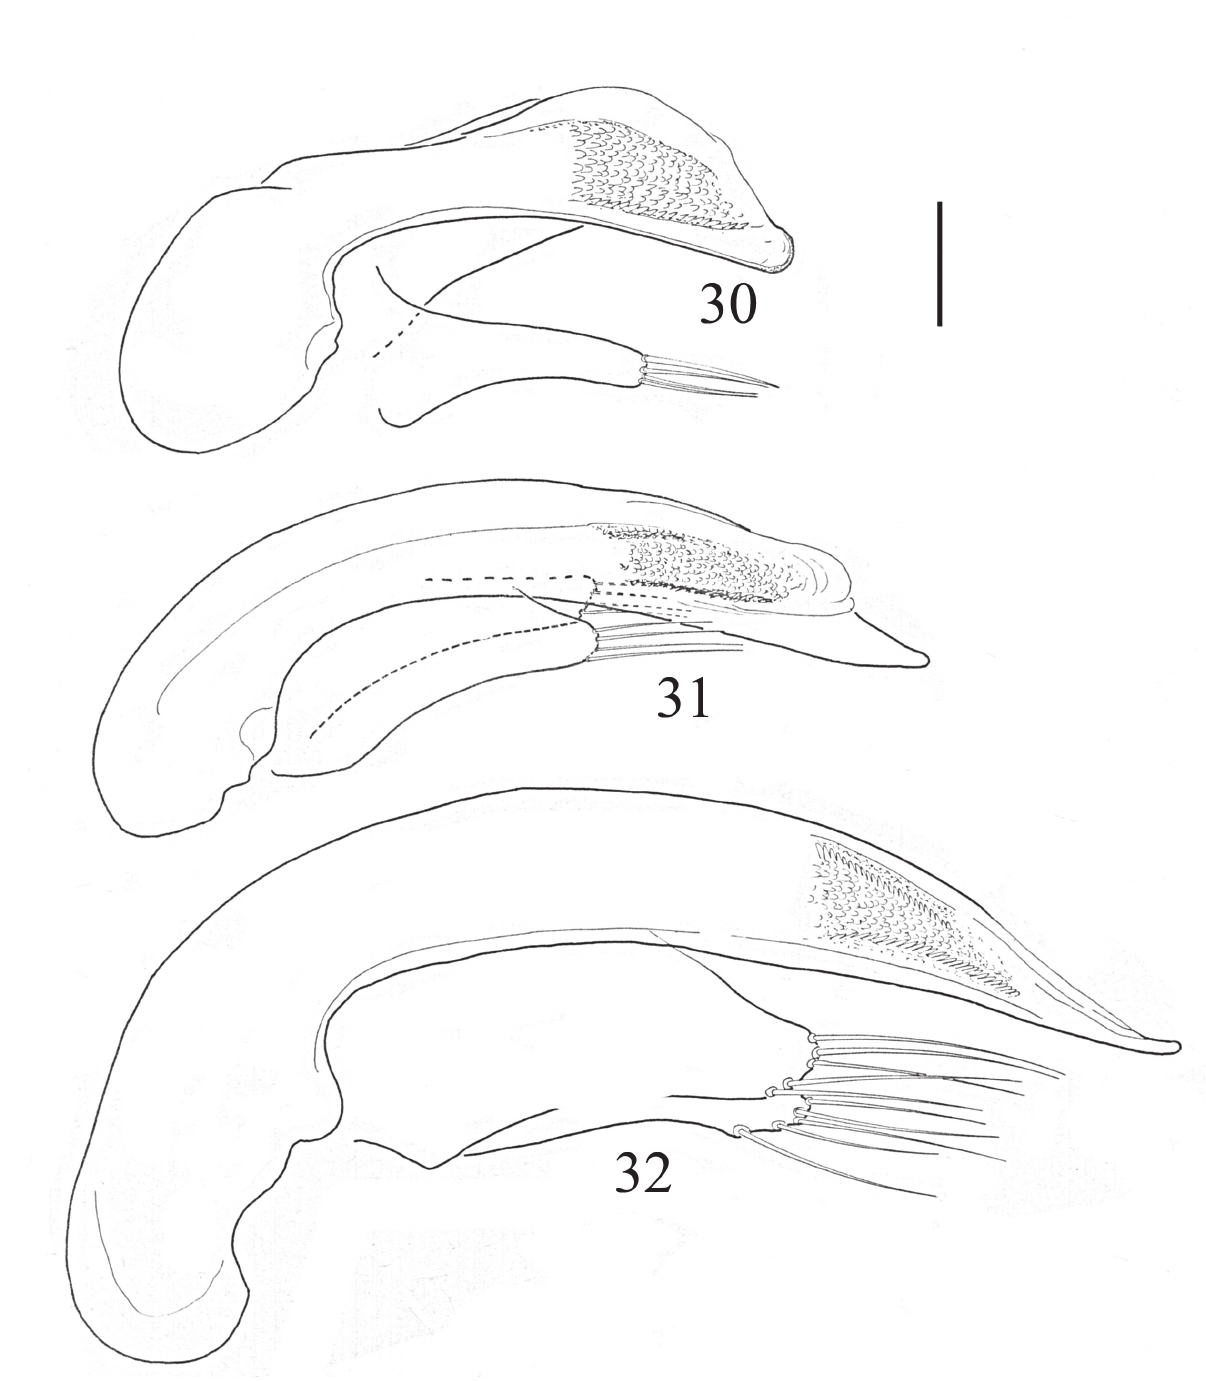
Figs 30-32. Aedeagus in lateral view of Tasmanorites spp.: 30) T. aberrans Moore, ♂ from Pillinger, Kelly Cove; 31) T. austrinus (Sloane), HT ♂ from Great Lake; 32) T. magnus Moore, ♂ from Ben Lomond. Scale: 0.1